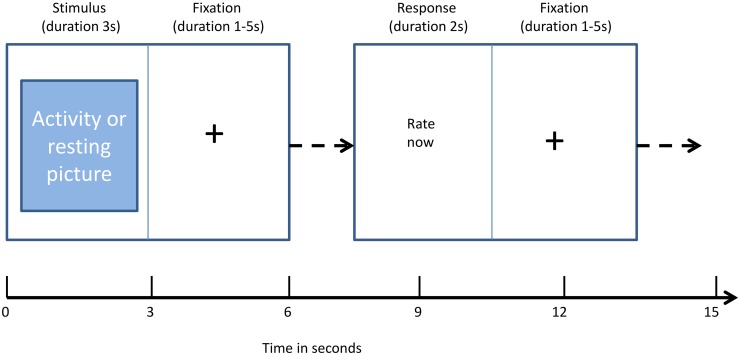
Trial timing.Each trial in the task lasted 7–15 s and was composed of 4 different screens; a photo from either PHODA or a resting activity, a fixation cross, a screen to indicate the subject should respond and ended with a second fixation cross.